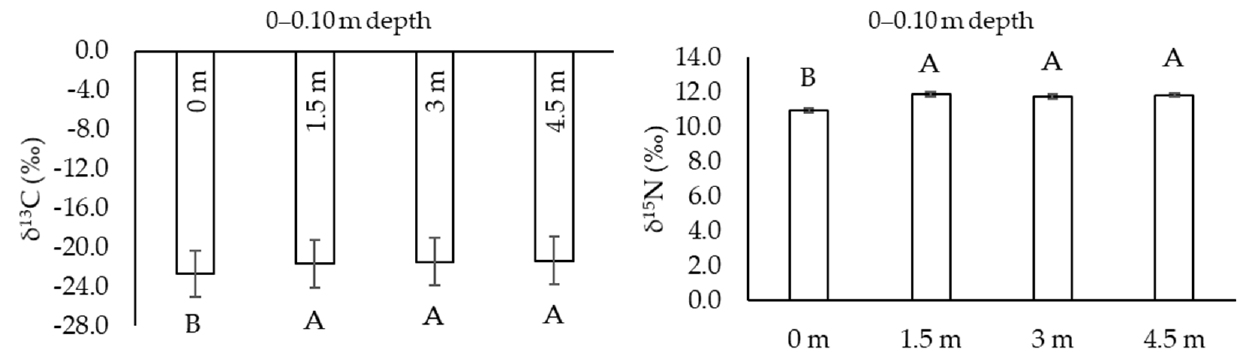
Figure 3. Isotopic natural abundance of δ 13 C and δ 15 N at different distances from the tree legumes intercropped with cactus, at the 0- to 10-cm layer. Different capital letters indicate significant difference ( p < 0.10) by PDIFF adjusted to Tukey. Bars indicate the standard error of the mean.